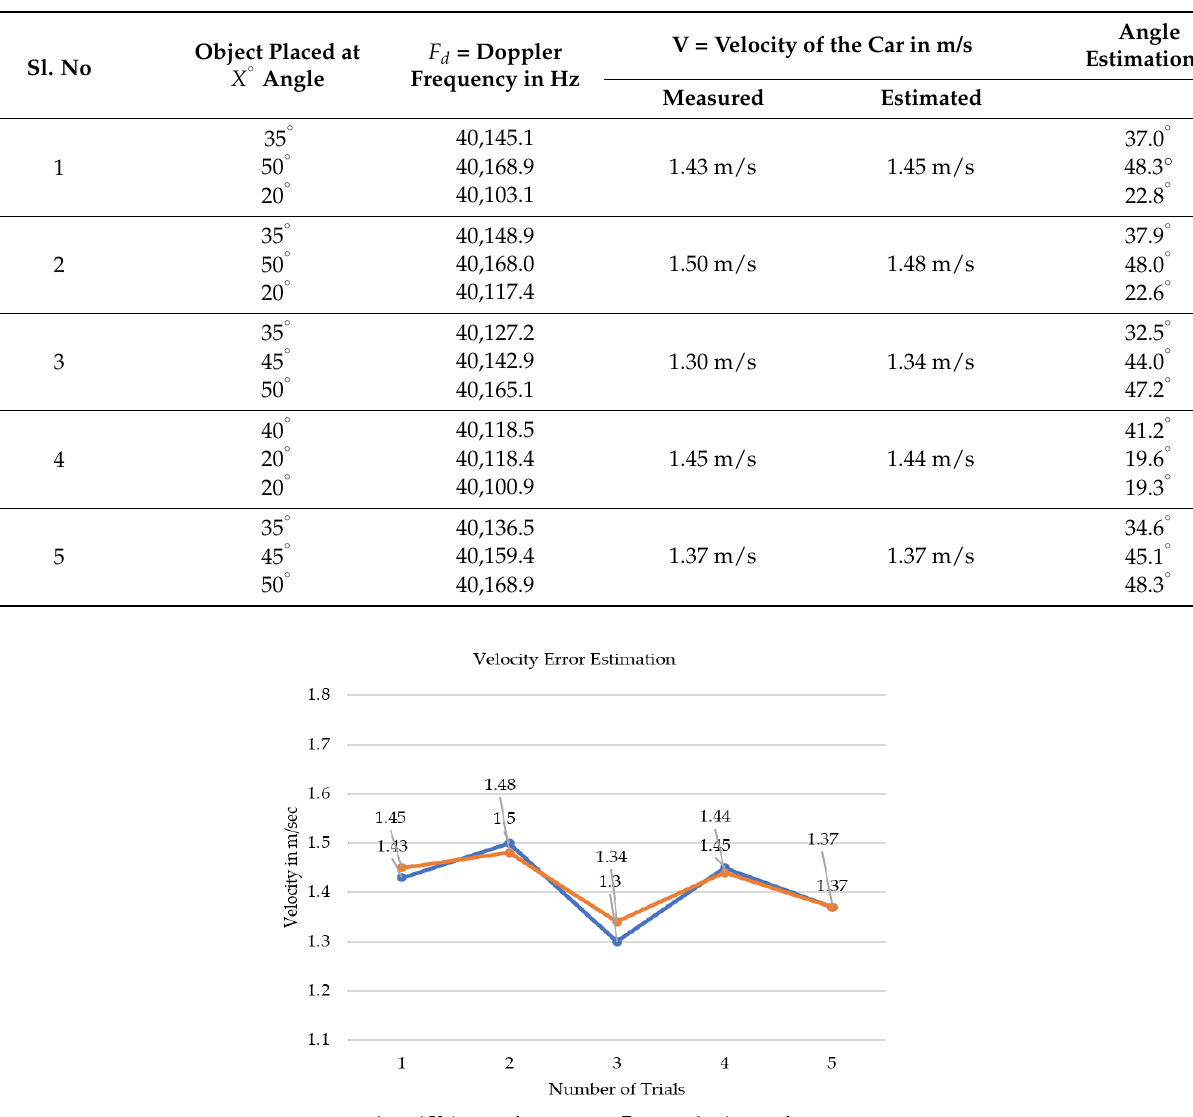
Table 4. The proposed method measures the estimation of vehicle speed, Doppler frequency shift, and azimuthal angle.